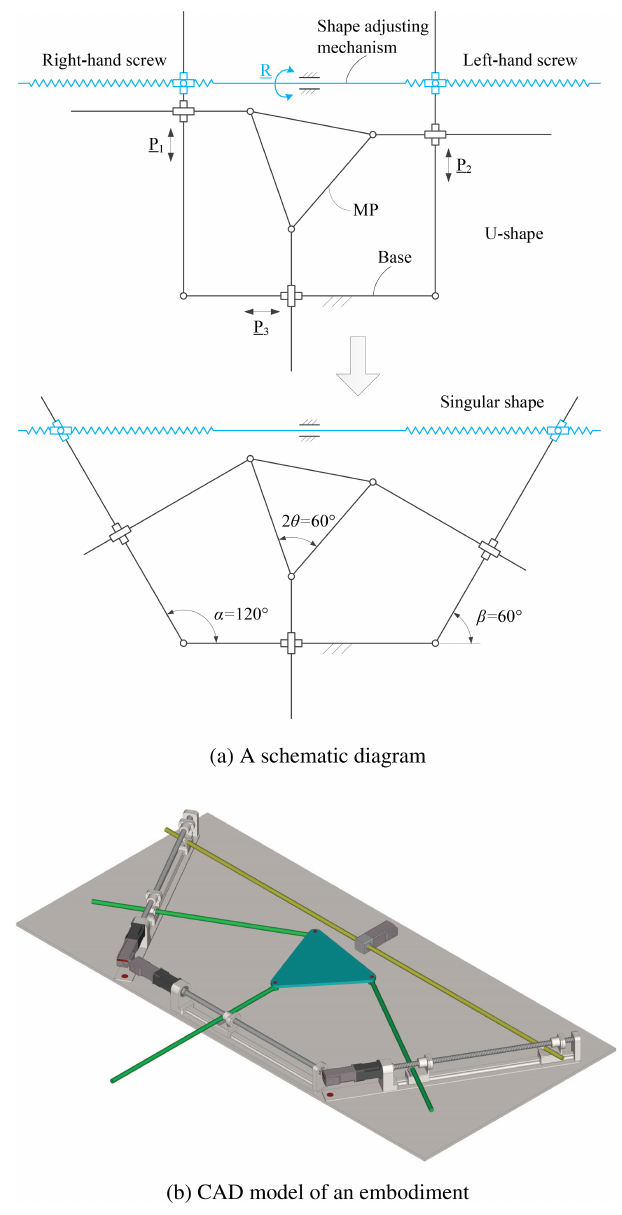
Figure 10. Compliance adjustable PKM by shape changing.